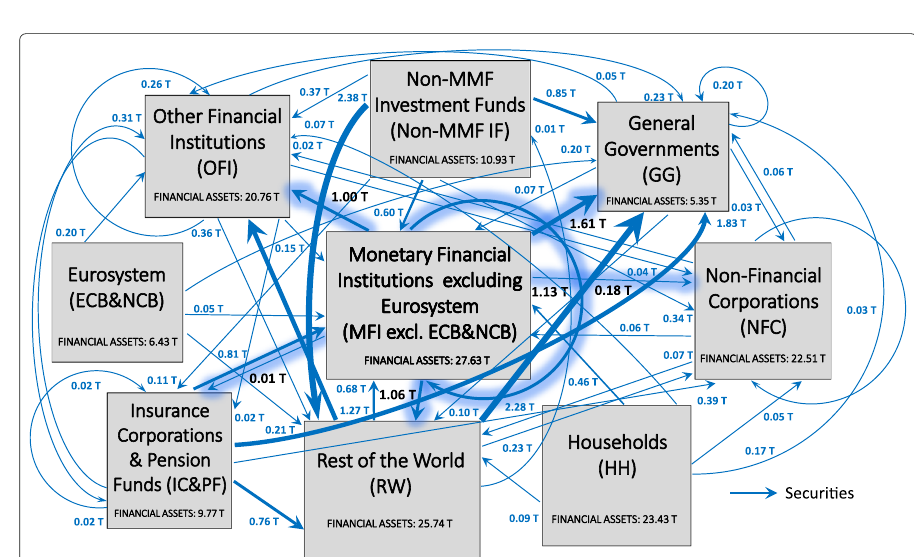
Fig. 6 The euro area macro-network of financial exposures via debt securities; June 2017. The macro-network of financial exposures among the different institutional sectors operating in the euro area (i.e., Eurosystem (ECB&NCB), Monetary Financial Institutions excluding the Eurosystem (MFI excl. ECB&NCB), Other Financial Institutions (OFI), Non-MMF Investment Funds (Non-MMF IF), Insurance Corporations and Pension Funds (IC&PF), Households (HH), Non-Financial Corporations (NFC), and General Governments (GG)), and the Rest of the World (RW), via short-term and long-term private and public debt securities (represented with blue links) excluding APP securities, with reference to the second quarter of 2017. Weights represent the outstanding financial exposures of a source institutional sector to a target institutional sector expressed in trillion euros. Data source: (European Central Bank